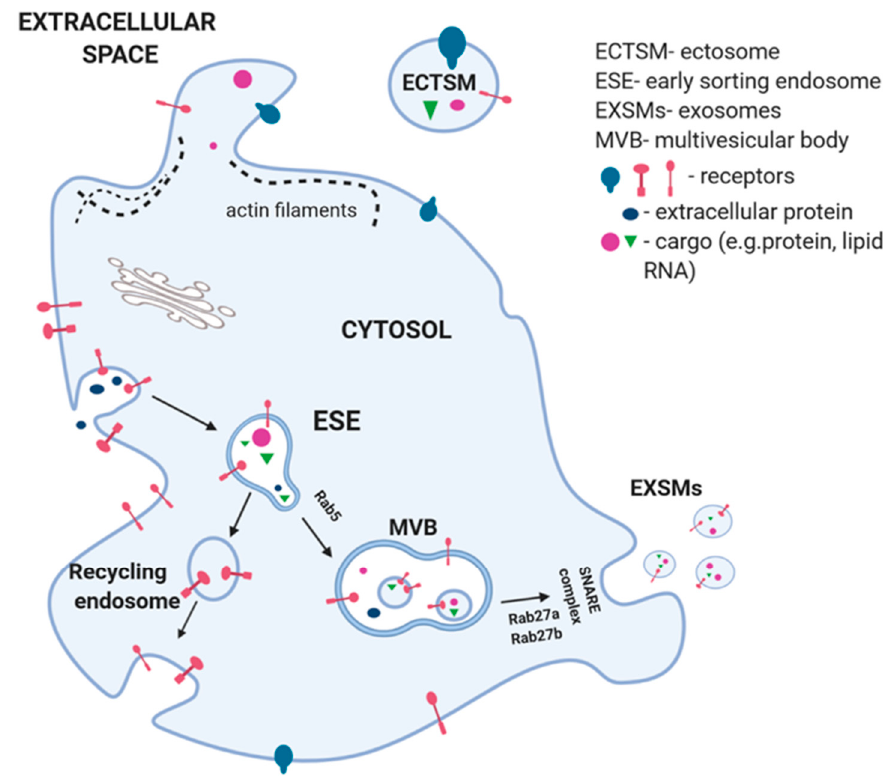
Figure 1. Extracellular vesicle biogenesis and secretion. The exosomes (EXSMs) generation begins with the membrane bulging into the lumen of the ESE. Part of them form a part of the plasma membrane (recycling endosome), others are converted into multi vesicular body (MVB). Members of the Rab family, Rab27a and Rab27b, are involved in MVB transport and fusion with cell membrane. Transmembrane protein complex SNARE enables the MVB to dock with the cell membrane that leads to release of EXSMs to extracellular space. Ectosome (ECTSM) are formed directly by cell membrane blebbing. This process is initiated with an increase in intracellular calcium that causes the activation of enzymes— floppase and scramblase and the inhibition of flippase. This causes the rearrangement of phospholipids in the cell membrane, as well as results in breaking bonds between cytoskeleton and partial degradation of actin filaments. During formation of EXSMs and ECTSMs, mRNA and miRNA that are located in cytoplasm are randomly entered.